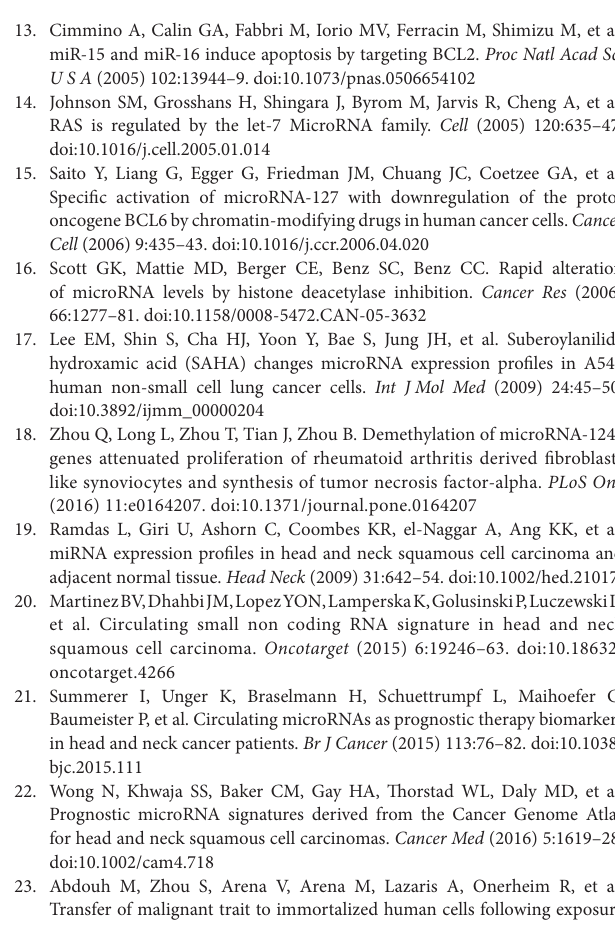
FigUre s1 | KEGG pathway (40) analysis: pathways in cancer. Diagram of pathways in cancer genes and interactions. Genes highlighted in yellow are targeted by one of the differently expressed microRNA (miRNA) and genes highlighted in orange are targeted by more than one miRNA. FigUre s2 | KEGG pathway (40) analysis: proteoglycans in cancer. Diagram of pathways in cancer genes and interactions. Genes highlighted in yellow are targeted by one of the differently expressed microRNA (miRNA) and genes highlighted in orange are targeted by more than one miRNA. FigUre s3 | KEGG pathway (40) analysis: TGF- β signaling pathways. Diagram of pathways in cancer genes and interactions. Genes highlighted in yellow are targeted by one of the differently expressed microRNA (miRNA) and genes highlighted in orange are targeted by more than one miRNA. FigUre s4 | KEGG pathway (40) analysis: FoxO signaling pathway. Diagram of pathways in cancer genes and interactions. Genes highlighted in yellow are targeted by one of the differently expressed microRNA (miRNA) and genes highlighted in orange are targeted by more than one